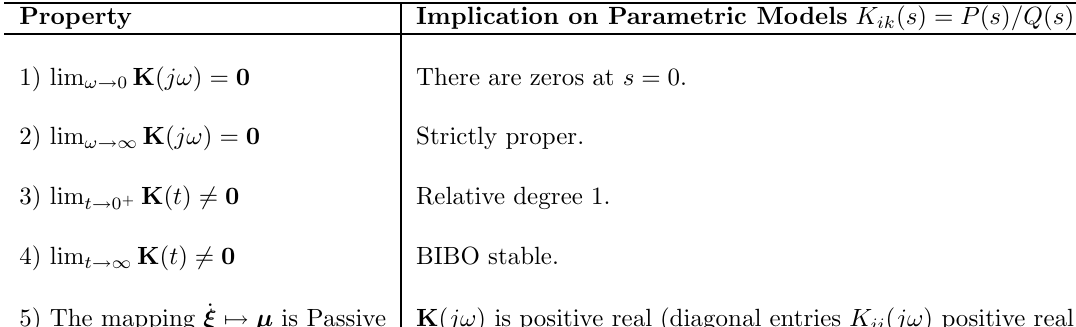
Table 2: Properties of Retardation